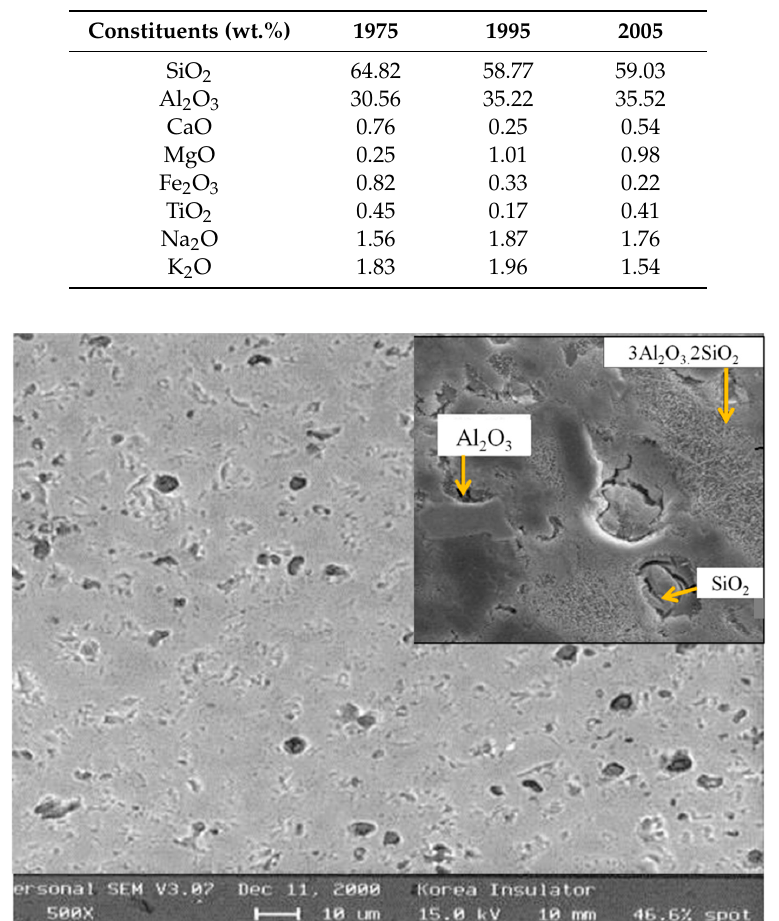
Figure 4. Microstructure of insulator sample A depicting a high porosity of the porcelain body. 3. Statistical Analysis of the Constituents of Porcelain and the Probability of Failure of Porcelain Insulators